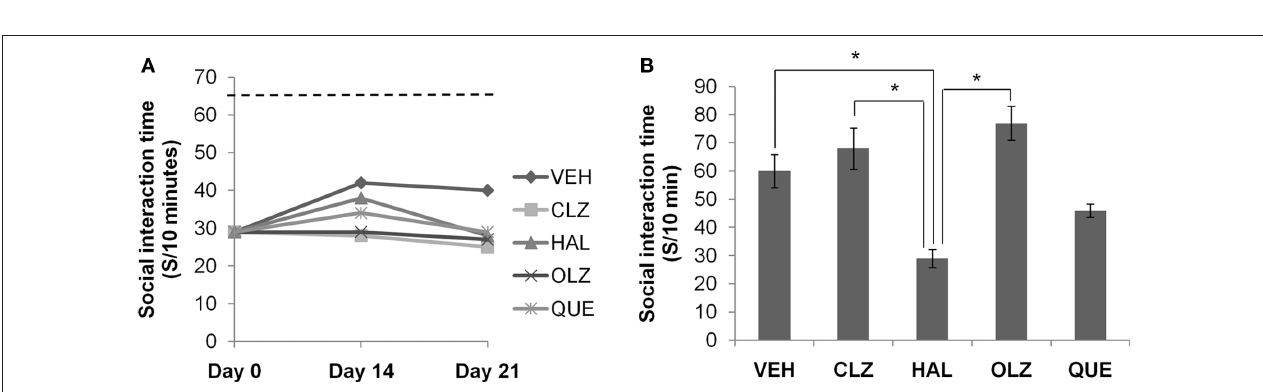
Figure 2 | Complete recovery of abnormal elevated plus-maze behavior after CPZ withdrawal. (A) The data from the recovery experiment, in which the dotted line indicates the value of the controls (CNT) never exposed to CPZ or antipsychotic drugs. (B) The data from mice exposed to antipsychotics, but not to CPZ. Data are mean ± SEM ( n = 6–12/group). VEH, vehicle; CLZ, clozapine; HAL, haloperidol; OLZ, olanzapine; QUE, quetiapine.